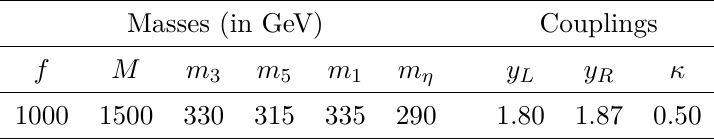
Table 4 . Choice of benchmark parameters used in this